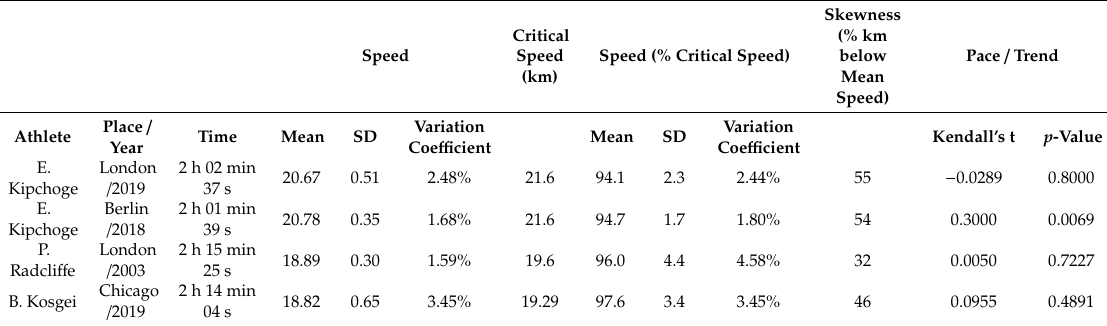
Table 1. Average marathon speed relative to male and female marathoners’ critical speed and coe ffi cient of speed variation.